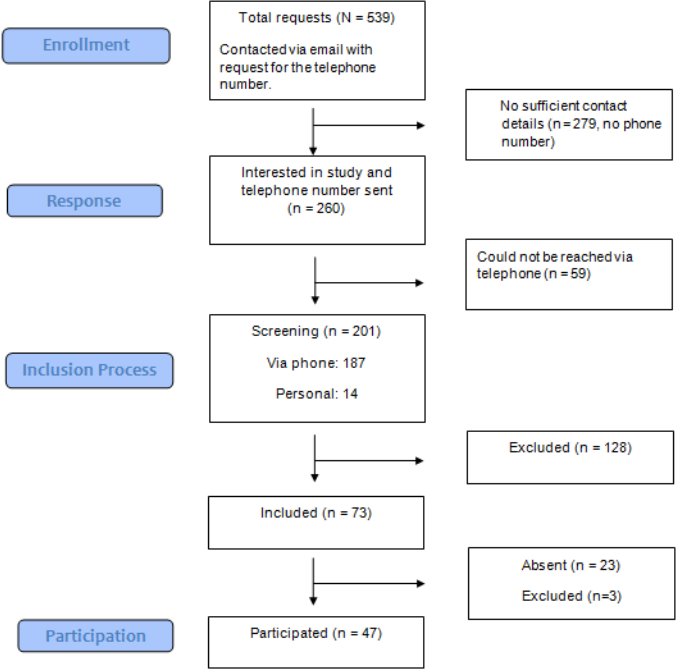
Figure 1. Recruitment of the hypersexual disorder group.